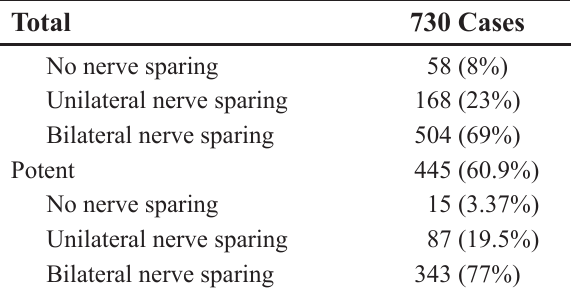
Table 4 – Data regarding erectile function and neurovas- cular bundle